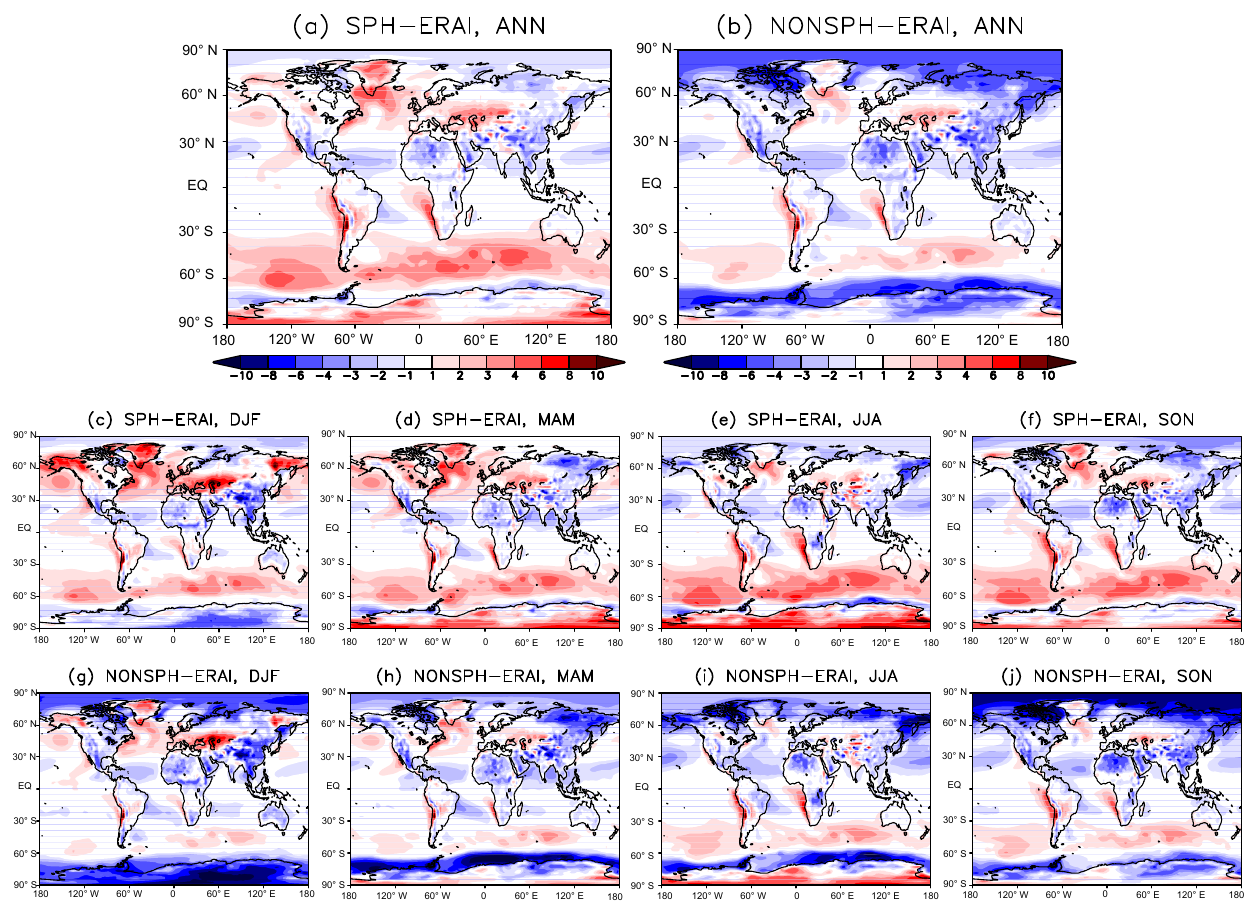
Figure 4. Annual-mean differences (K) in 2m air temperature (a) between the SPH experiment and the ERA-Interim reanalysis (averaged over the years 1990–2014) and (b) between NONSPH and ERA-Interim. (c)–(f) Corresponding seasonal-mean differences between SPH and ERA-Interim and (g)–(j) between NONSPH and